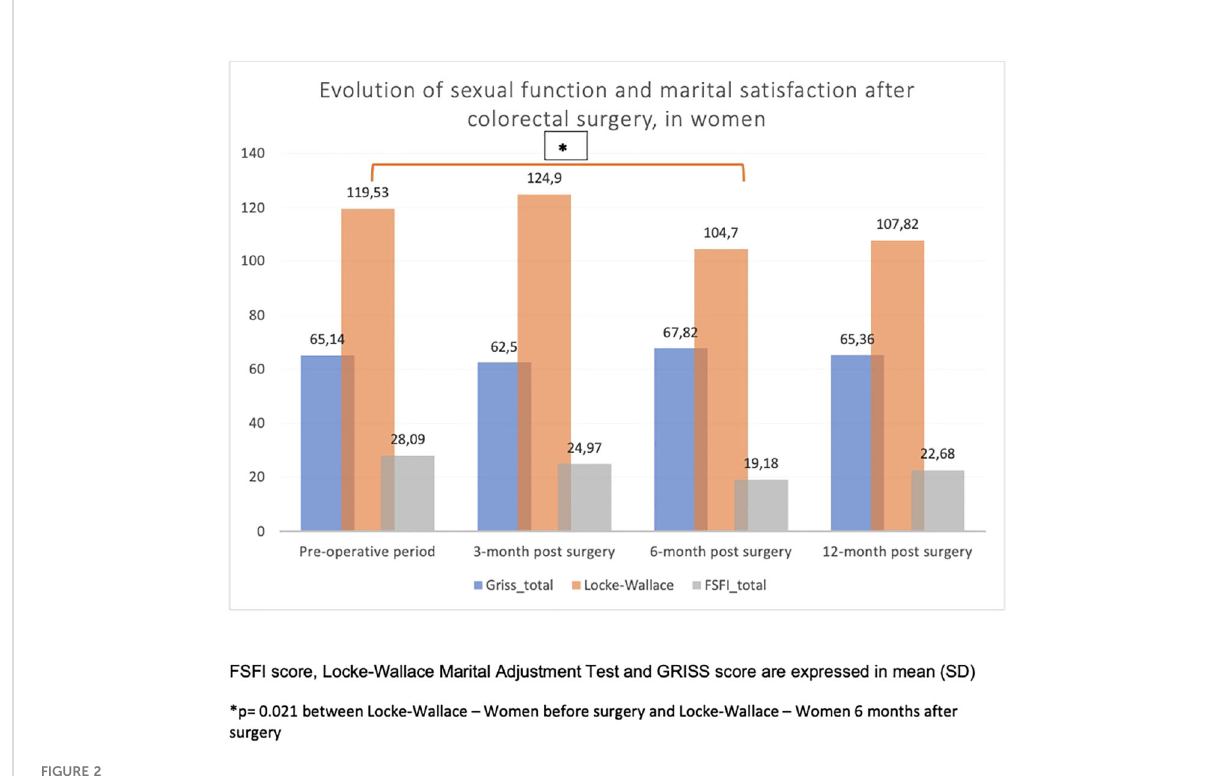
FIGURE 2 Evolution of sexual function and marital satisfaction after colorectal surgery, in women.